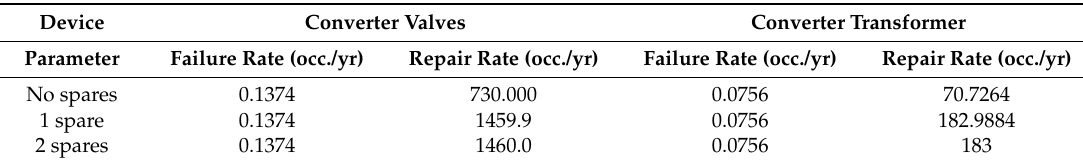
Table 7. Reliability parameter analysis of specific